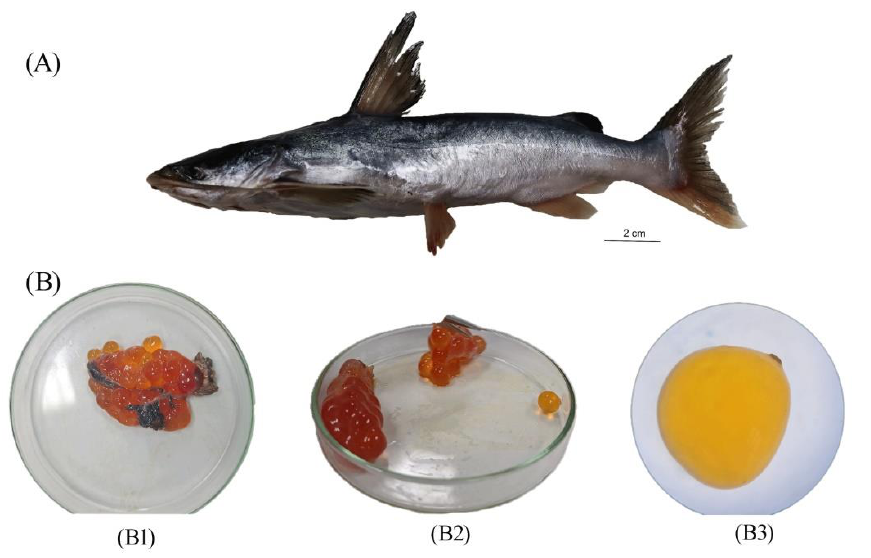
Figure 2. Fish samples in the study: ( A ) O. militaris or soldier catfish; ( B ) fish eggs randomly picked from mother catfish; ( B1 ) fish eggs taken from mother catfish; ( B2 ) each fish egg carefully separated; ( B3 ) appearance of a fish egg under a microscope .